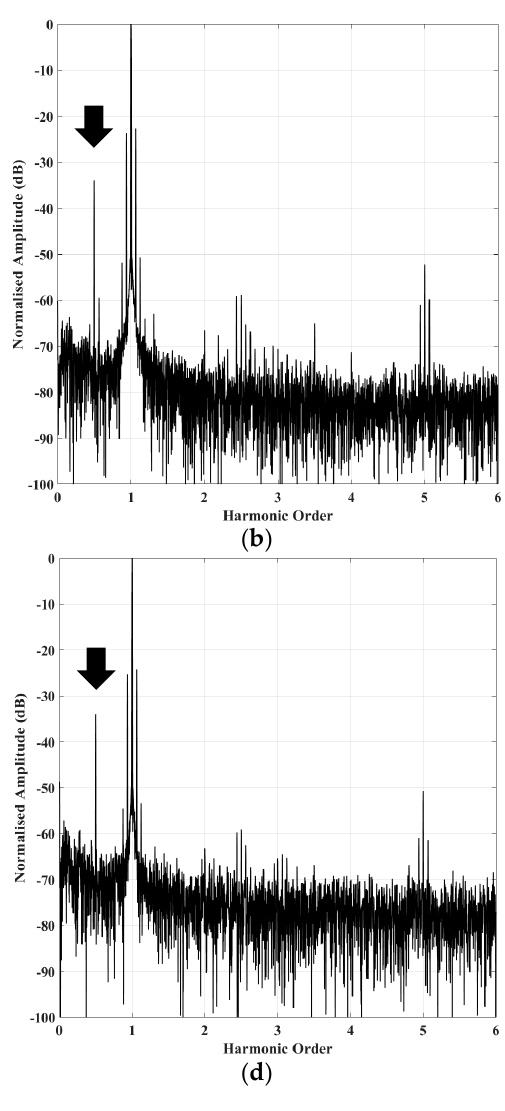
Figure A2. Experimental results. The current spectrum of the generator at 100 rpm: ( a ) Local demagnetization 5 kW; ( b ) Local demagnetization 4 kW; ( c ) Local demagnetization 2 kW; ( d ) Local demagnetization 1 kW.